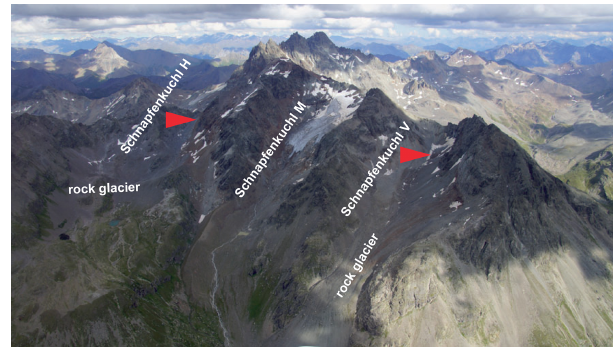
Figure 2. Aerial overview of the Schnapfenkuchl glaciers V, M, and H in an aerial photograph of 21 August 2020 (photograph by An- drea Fischer). While Schnapfenkuchl M still is a classic glacier with exposed bare ice, on Schnapfenkuchl H and V bare ice is rarely ex- posed. See the close-ups of the parts with ice exposed (red arrows) in Fig.